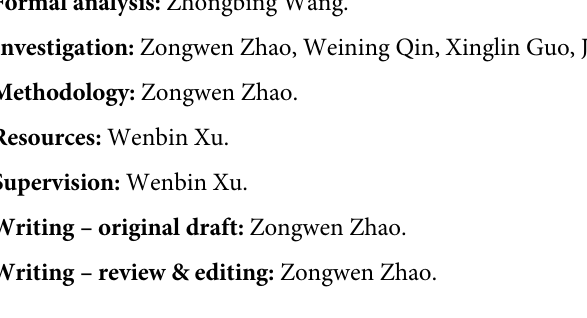
increasing the difficulty of resource utilization of the industrial waste salt.